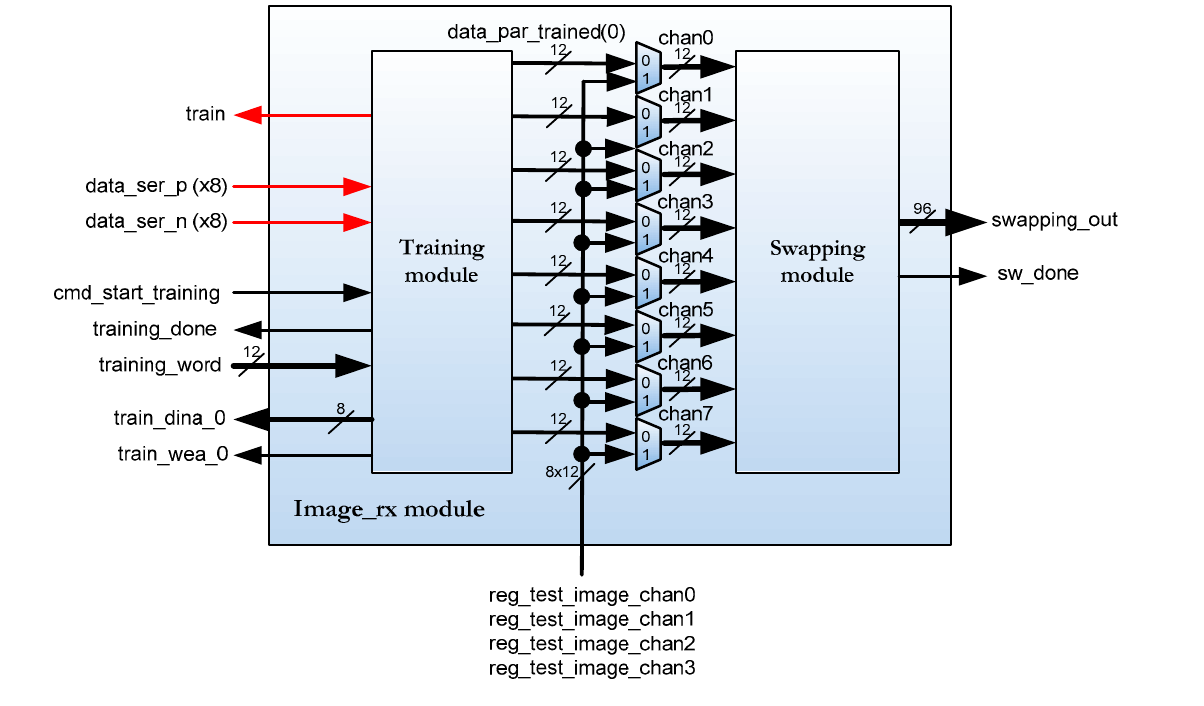
Figure 4. Image_rx block diagram.